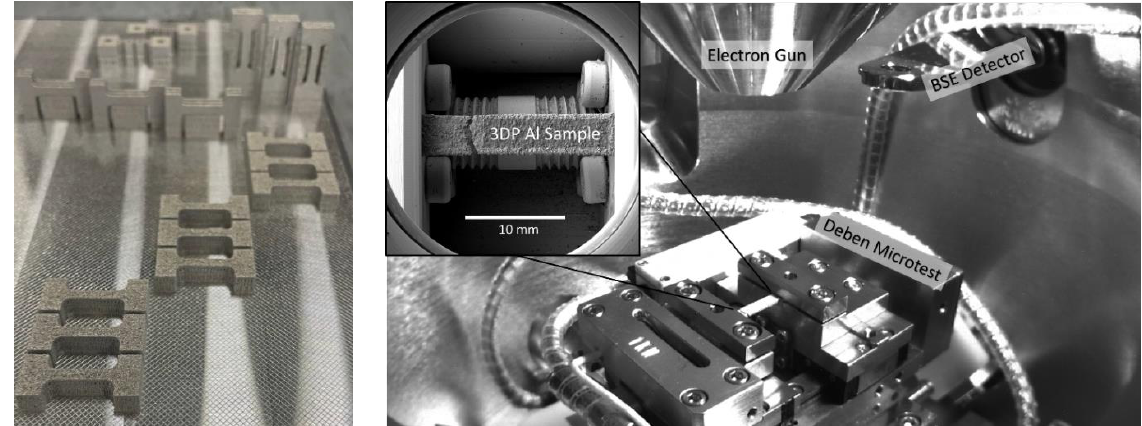
Figure 4. Appearance of 3D-printed specimens ( left ) and principal layout of experimental setup for in situ SEM study of mechanical response ( right ).